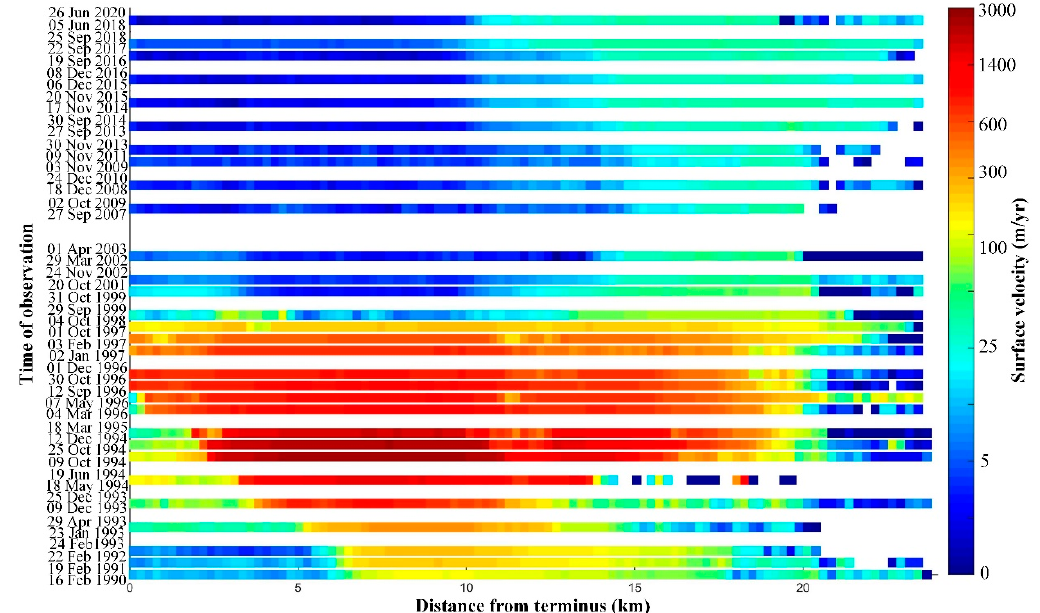
Figure 6. Evolution of the surface velocity along with the longitudinal profile (see Figure 1) from 1990 to 2020. Note that the scale is logarithmic.